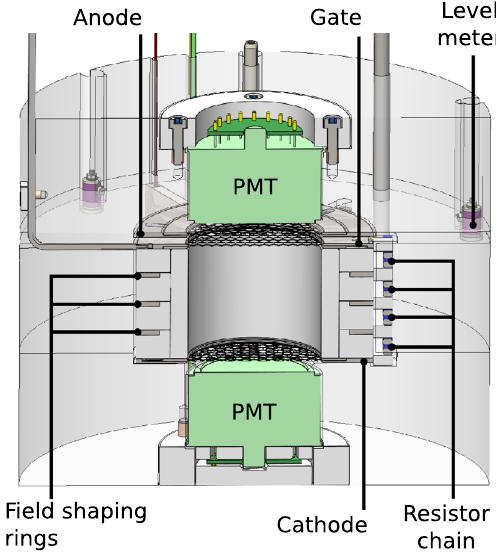
Fig. 1 Schematic figure of the HeXe TPC with its components